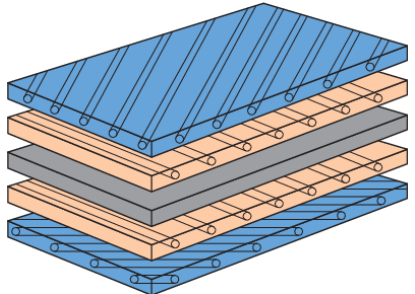
Figure 7. Multidirectional laminated composite structure.